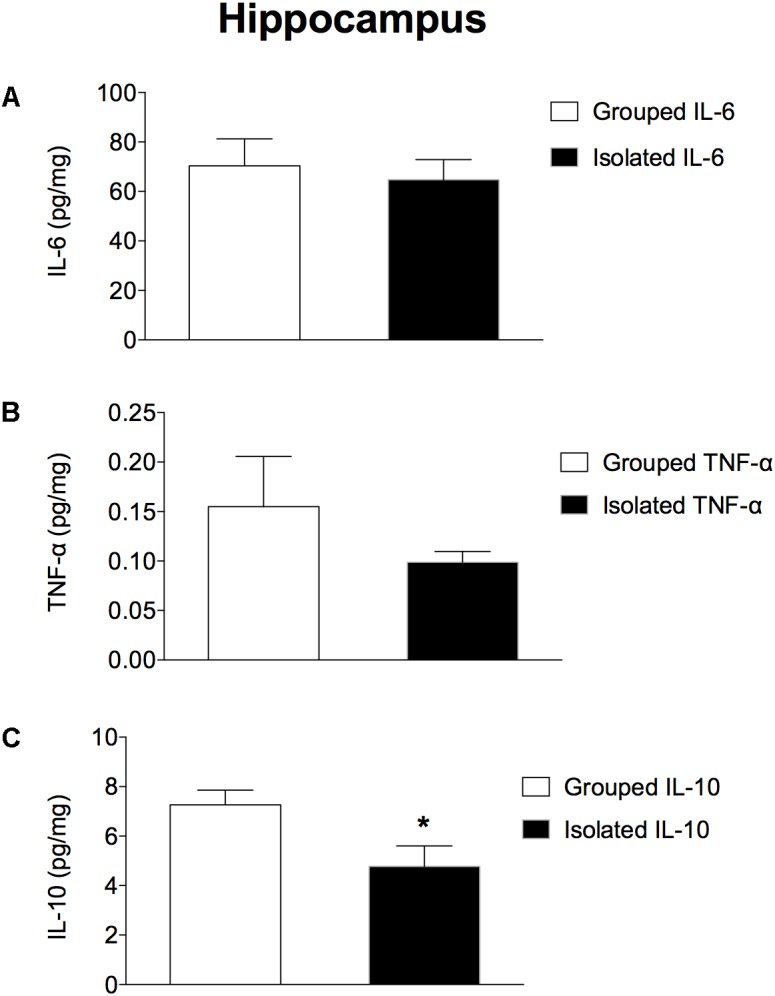
Effect of rearing condition (isolated vs. grouped) on cytokines in the hippocampus of rats exposed to 10 weeks of social isolation. Rats reared isolated (n = 9) presented lower levels of (C) IL-10, with no differences for (B) TNF-α or (A) IL-6 when compared to controls (n = 8). Data are expressed as mean ± S.E.M and given as pg/mg. ∗p < 0.05 (Student’s t-test) compared to grouped rats.